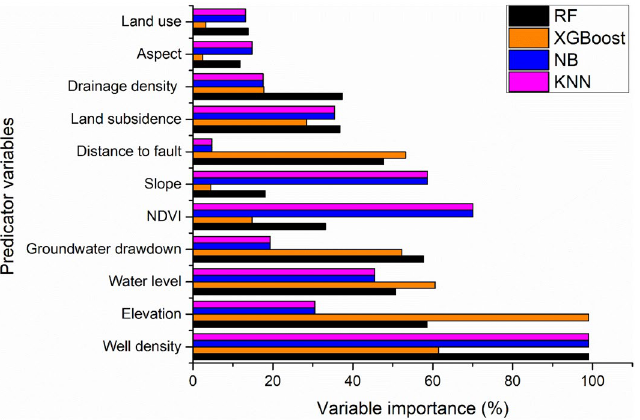
Figure 10. The importance rank of the earth fissure predictors (Developed by the first author using graphpad (v.9.2.0) https:// www. graph pad.